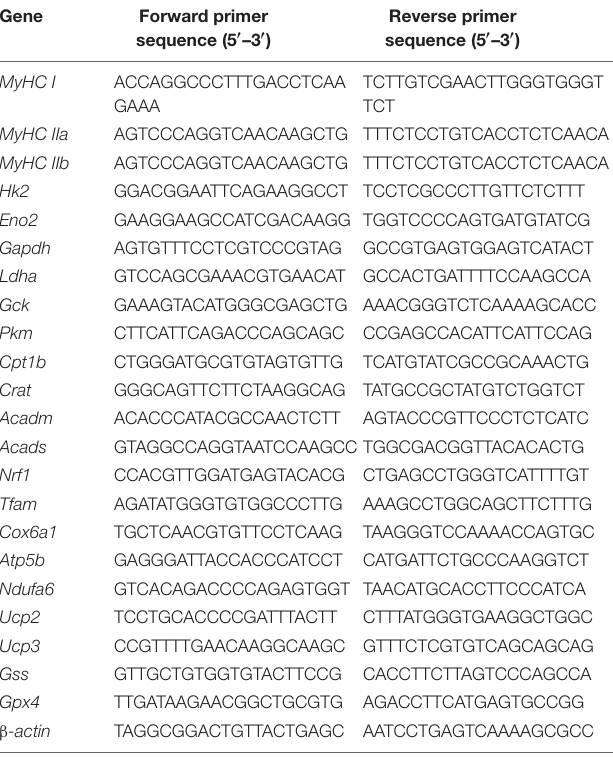
TABLE 1 | Primer sequences used for qRT-PCR. Gene Forward primer sequence (5 (cid:48) –3 (cid:48) )